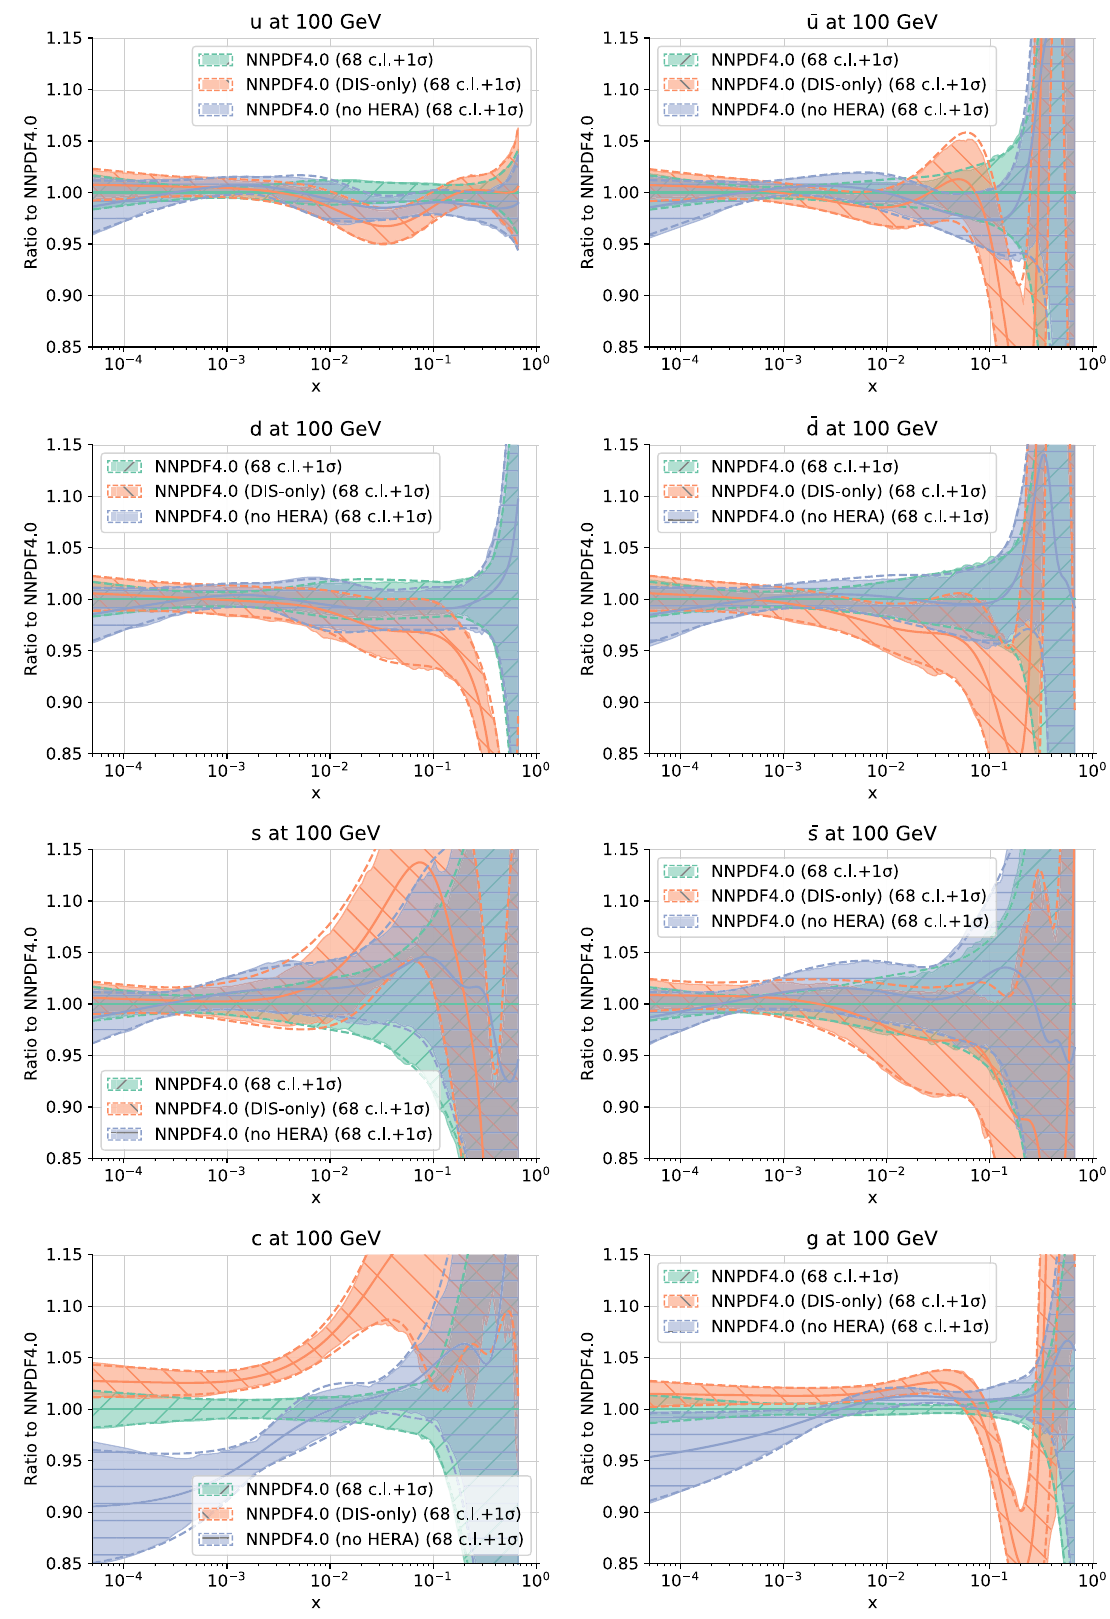
Fig. 40 Same as Fig. 31 now comparing the baseline to PDFs determined from DIS data only, or removing all HERA